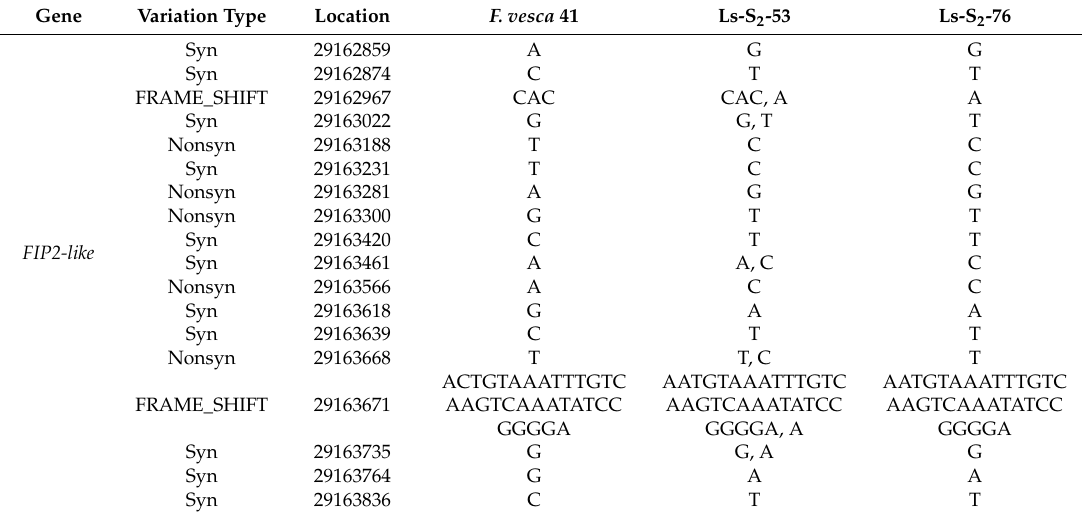
Figure 9. Sequence analysis of FIP2-like ( FIP2-like ). ( a ) Amino acid sequence alignment of FIP2-like of F. vesca 41 and Ls-S 2 -76 harbor P1 and P3, respectively, and Ls-S 2 -53 which harbors P2 and P3. ( b ) The full length of the FIP2-like gene. 1, 2 are obtained using the DNA and anther cDNA of F. vesca 41 as templates, respectively; 3 and 4 are respectively obtained using Ls-S 2 -53 and Ls-S 2 -76 anther cDNA as templates. ( c ) Contained structural domain of FIP2-like from P1, P2, and P3. Table 4. Variations of FIP2-like in F. vesca 41, Ls-S 2 -76, and Ls-S 2 -53.